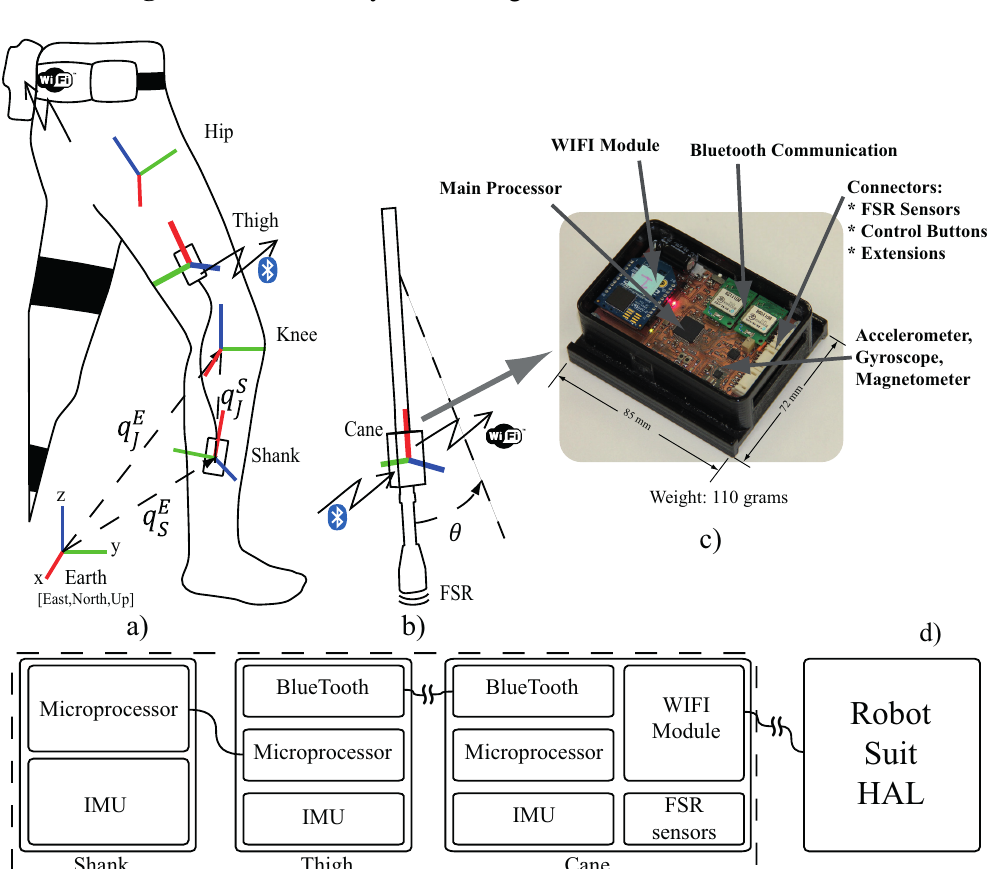
Figure 4. Wearable system configuration and frame